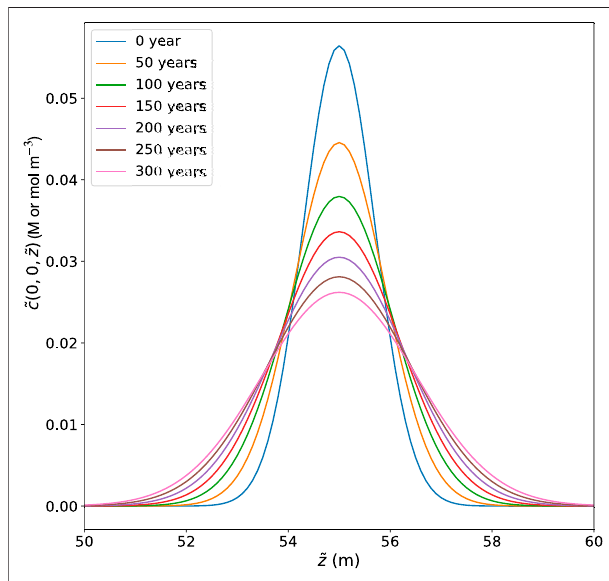
FIGURE 3 | Evolution of the nutrient concentration (in units of M, or mol m − 3 ) along the ~ z -axis, computed from Eq. 33 , at ~ x (cid:2) ~ y (cid:2) 0. At ~ t (cid:2) 0, the nutrient concentration is centered at ~ z 0 (cid:2) 55m and the nutrient diffusivity is ~ D (cid:2) 10 − 10 m 2 s − 1 . ch